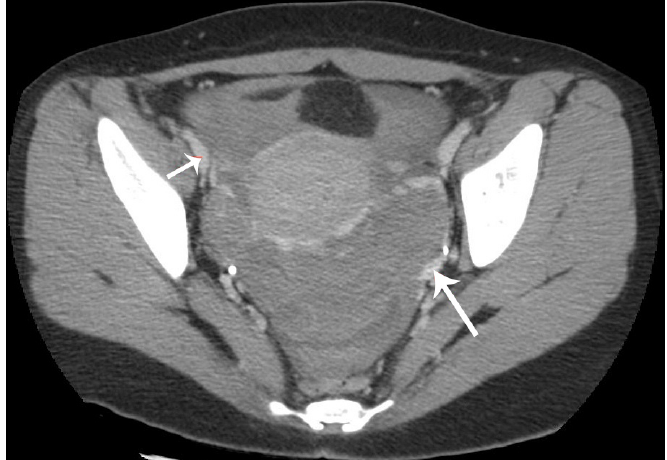
Figure 2. Chest computed tomography demonstrating multiple discrete pulmonary nodules